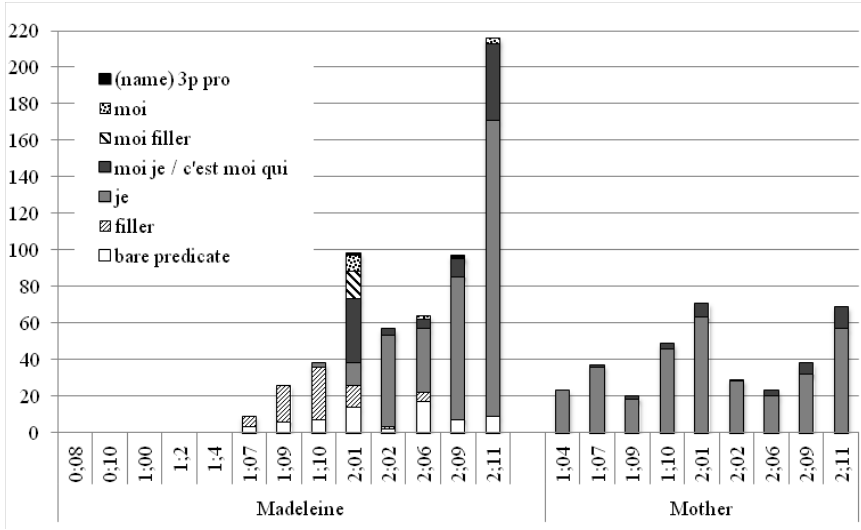
Figure 6 . Subject self-reference in Madeleine’s data according to age in comparison with her mother’s overall forms of